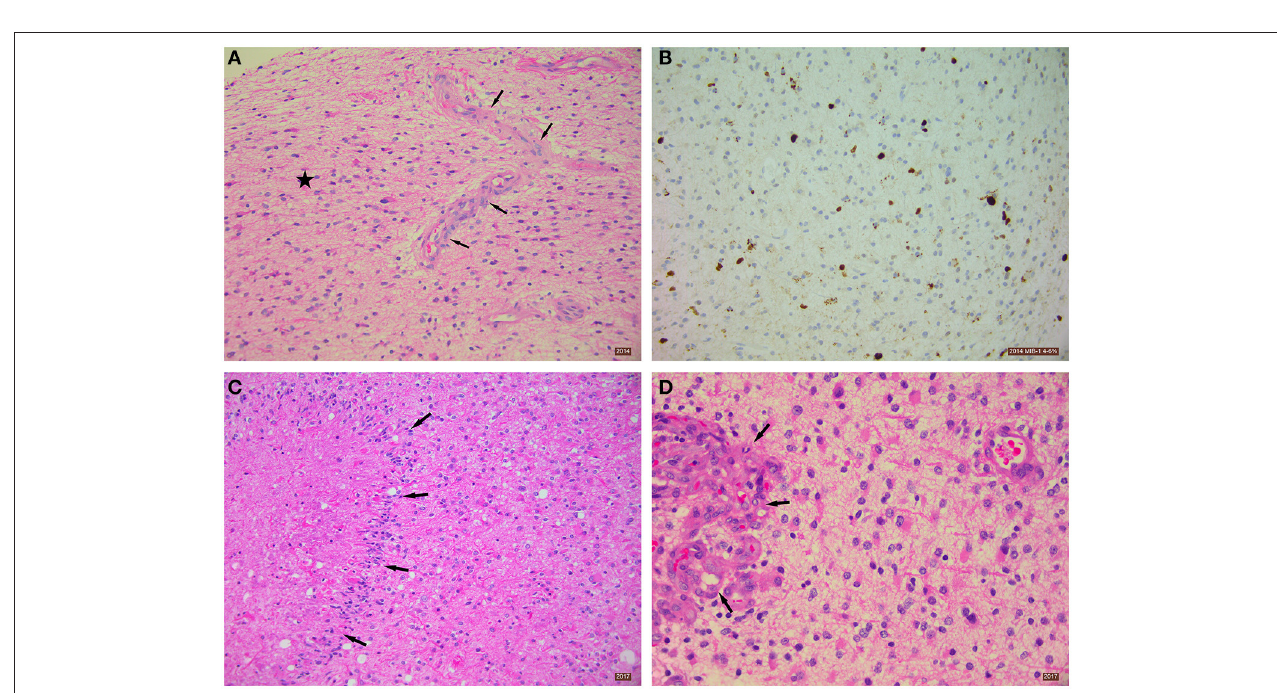
FIGURE 1 | lesion in the premotor cortex is clearly seen in (C). Please note that the surgical debulking involved only the enhancing tumor, while the largest non-enhancing part of the GBM was not excised by the neurosurgeon. The most recent brain MRI (D–F) shows interval increase in size of the GBM (arrowheads),